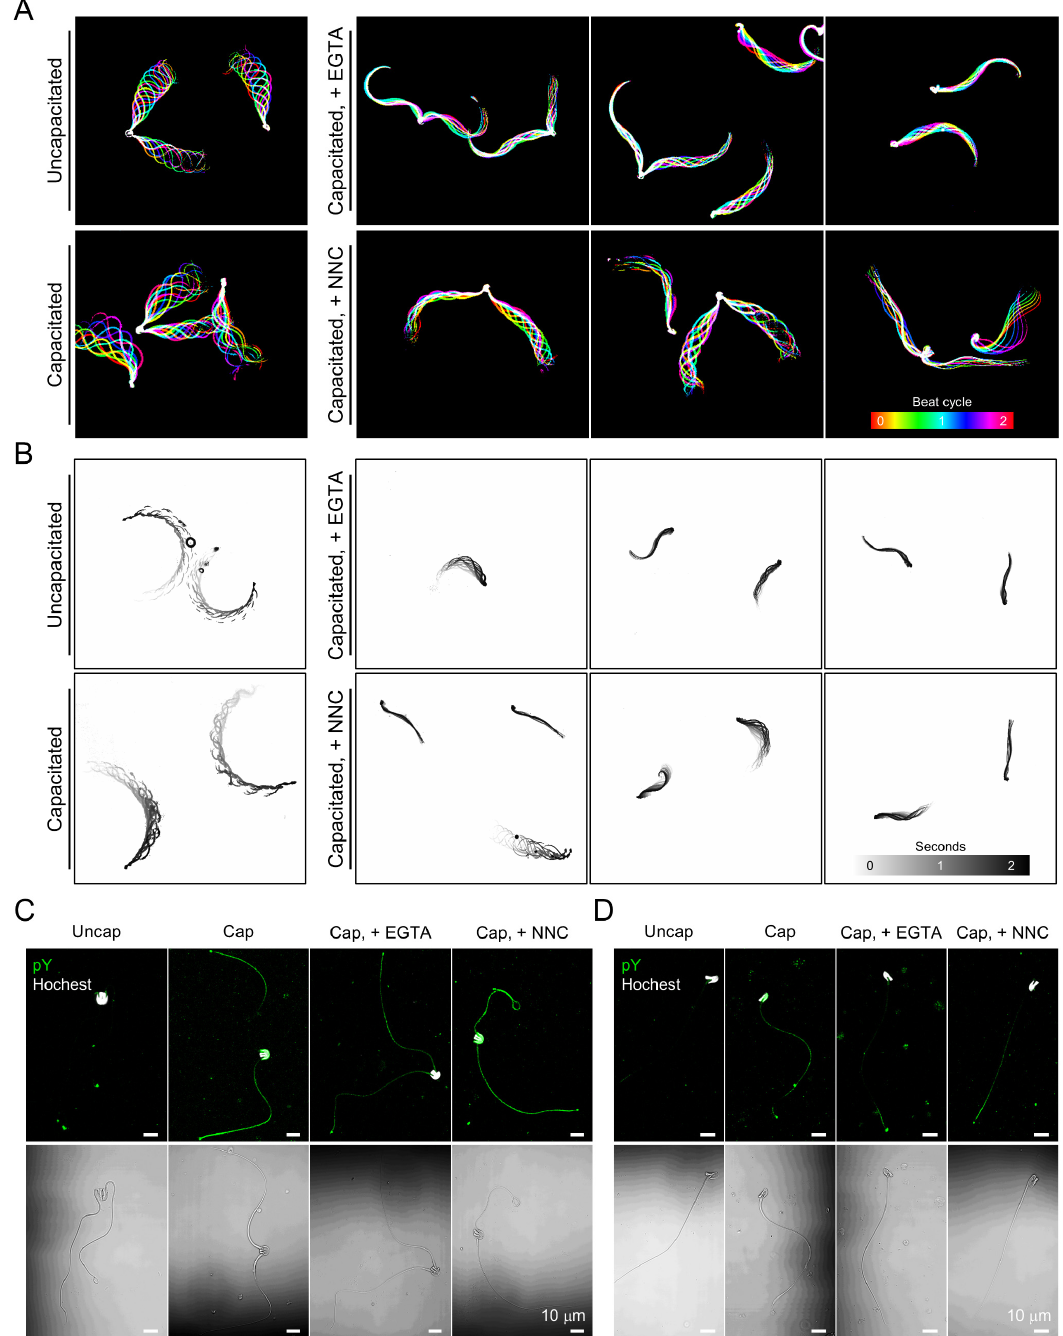
Figure 4. Inhibition of extracellular Ca 2+ influx impairs hyperactivated motility in the capacitated opossum sperm. ( A ) Flagellar waveform analysis of sperm incubated under the capacitating condition with blocking Ca 2+ entry. Opossum sperm were capacitated with EGTA (right-top) or CatSper channel inhibitor, NNC 55-0396 (NNC, right-bottom), and their flagellar movement was recorded. Inhibiting Ca 2+ influx compromises opossum sperm to develop hyperactivated motility with increased flagellar amplitude. Flagellar movement during two beating cycles was overlaid and represented in color-coded images. ( B ) Swimming trajectory of the opossum sperm capacitated under impaired Ca 2+ entry condition. Movements of free-swimming sperm were recorded for two seconds, and the swimming trajectory was visualized by overlaying time-laps frames. Sperm flagellar movement ( A ) and swimming trajectories ( B ) were recorded in H-HTF medium supplemented with 0.5% methylcellulose. ( C , D ) Confocal images of immunostained phosphotyrosine (pY) in paired ( C ) or single ( D ) opossum sperm capacitated with EGTA or NNC. Corresponding DIC images are shown below. Sperm heads were counter-stained with Hoechst. ( A – D ) 2.5 mM of EGTA and 10 mM of NNC were used. See also Figure S3 and Videos